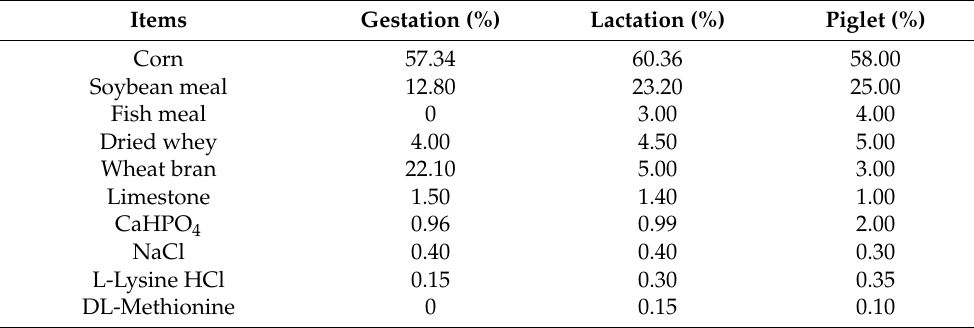
Table 1. Ingredient and nutrient levels of basal diet in each